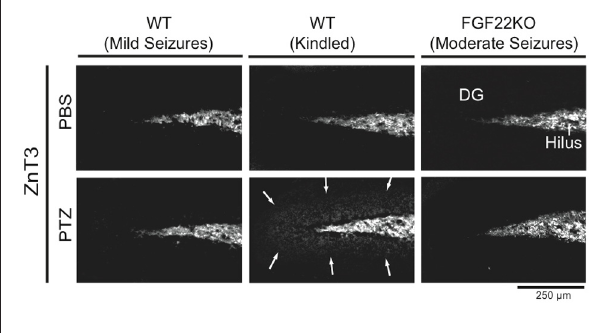
FIGURE 6 | MFS is only induced in kindled WT mice. Region-matched sagittal hippocampal sections were prepared from PBS- and PTZ-injected WT and FGF22KO mice (3 groups of mice as shown in Figure 1 ) and stained for ZnT3, a zinc transporter enriched in mossy fiber terminals, to examine MFS in the DG. Kindled WT mice show MFS in the dentate molecular layer (arrows), while non-kindled WT and FGF22KO mice do